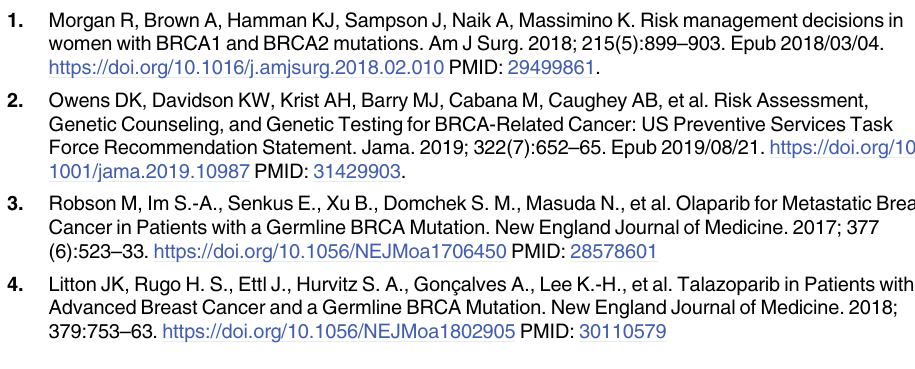
S1 Table. List of detected BRCA1, BRCA2 and PALB2 pathogenic variants of patients eli- gible in the study. Abbreviations: NA, Not